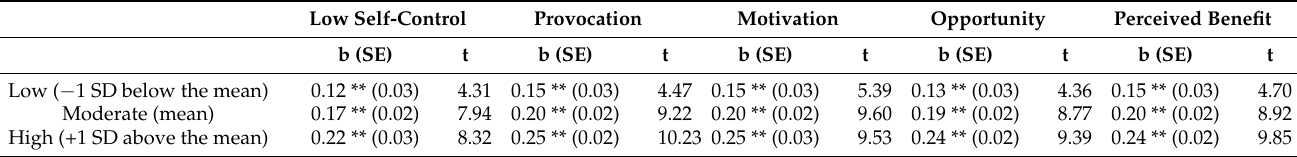
Table 4. Results for Slope of Regression Line Tests ( n = 410).